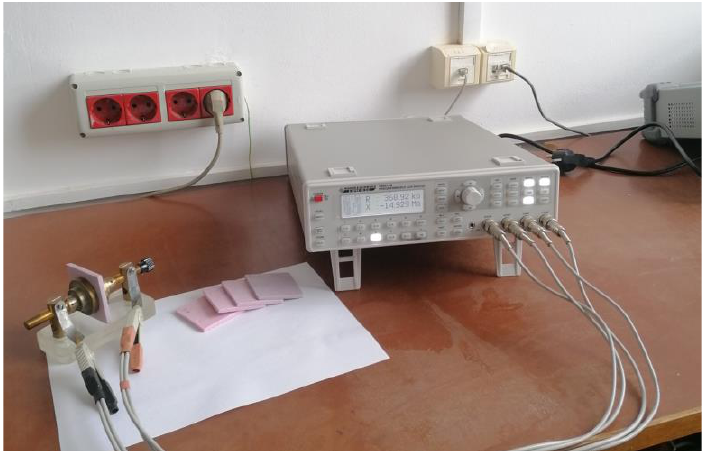
Figure 2. The images of the SR — xAl composite samples of silicone rubber with Al particles (x — volume fraction of Al particles): sample A (x = 0); sample B (x = 0.005); sample C (x = 0.01); sample D (x = 0.025); and sample E (x = 0.051).